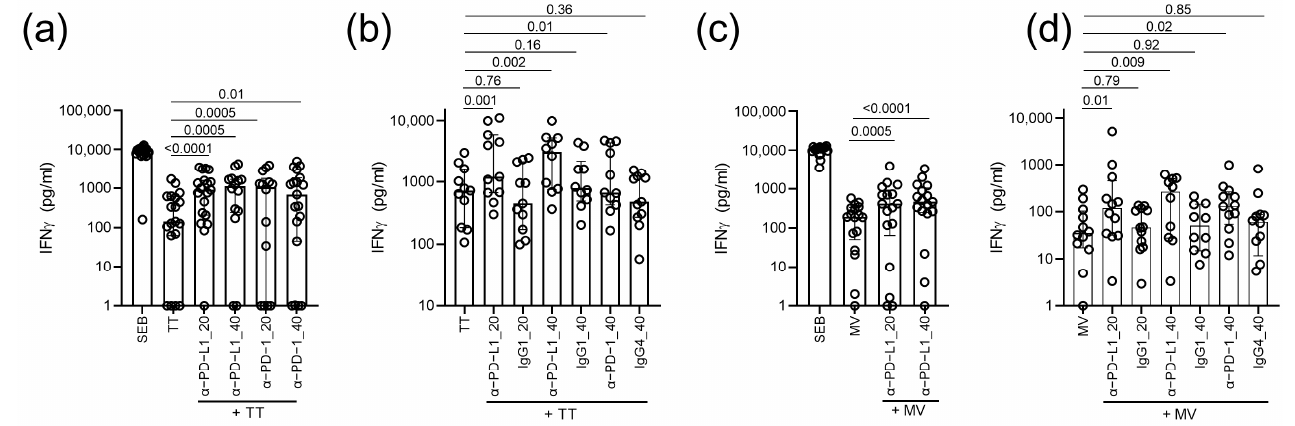
Figure 2. IFN γ responses upon ex vivo blockades of the PD-1 pathway. ( a ) TT-specific IFN γ responses of the HIV-infected TT-seropositive persons upon the addition of anti-PD-1 or anti-PD-L1 antibodies at concentrations of 20 or 40 µ g/mL. ( b ) TT-specific IFN γ responses of a separate set of the HIV-infected TT-seropositive persons upon the addition of anti-PD-L1 (20 and 40 µ g/mL) or anti-PD-1 (40 µ g/mL) and their respective isotype controls, namely, human IgG1 and human IgG4. ( c ) MV-specific IFN γ responses of the HIV-infected MV-seropositive persons upon the addition of anti-PD-L1 at concentrations of 20 or 40 µ g/mL. ( d ) MV-specific IFN γ responses of a separate set of HIV-infected MV-seropositive persons upon the addition of anti-PD-L1 (20 and 40 µ g/mL) or anti-PD-1 (40 µ g/mL) and their respective isotype controls human IgG1 and human IgG4. The background responses (unstimulated condition) were subtracted for each participant. Medians, interquartile ranges and p -values of the comparison between stimulation conditions using the Wilcoxon test are presented.